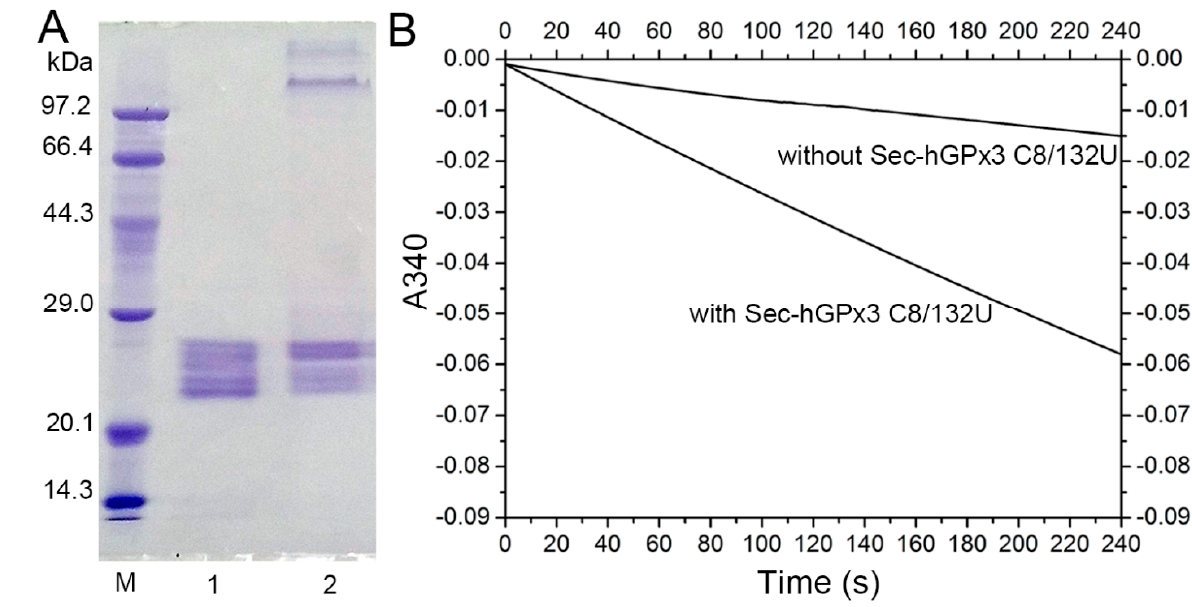
Figure 6. Expression of enzymatically active Sec − hGPx3 − C8/132U. ( A ) SDS − PAGE gel analysis of Sec − hGPx3 − C8/132U; Lane 1: reduced Sec − hGPx3 − C8/132U; Lane 2: non − reduced Sec − hGPx3 − C8/132U; ( B ) Reduction of t − BuOOH catalyzed by Sec − hGPx3 − C8/132U with 10 µ M GSH. The reactions were performed with 1 mM EDTA, 0.25 mM NADPH, 0.3 mM t − BuOOH, 1